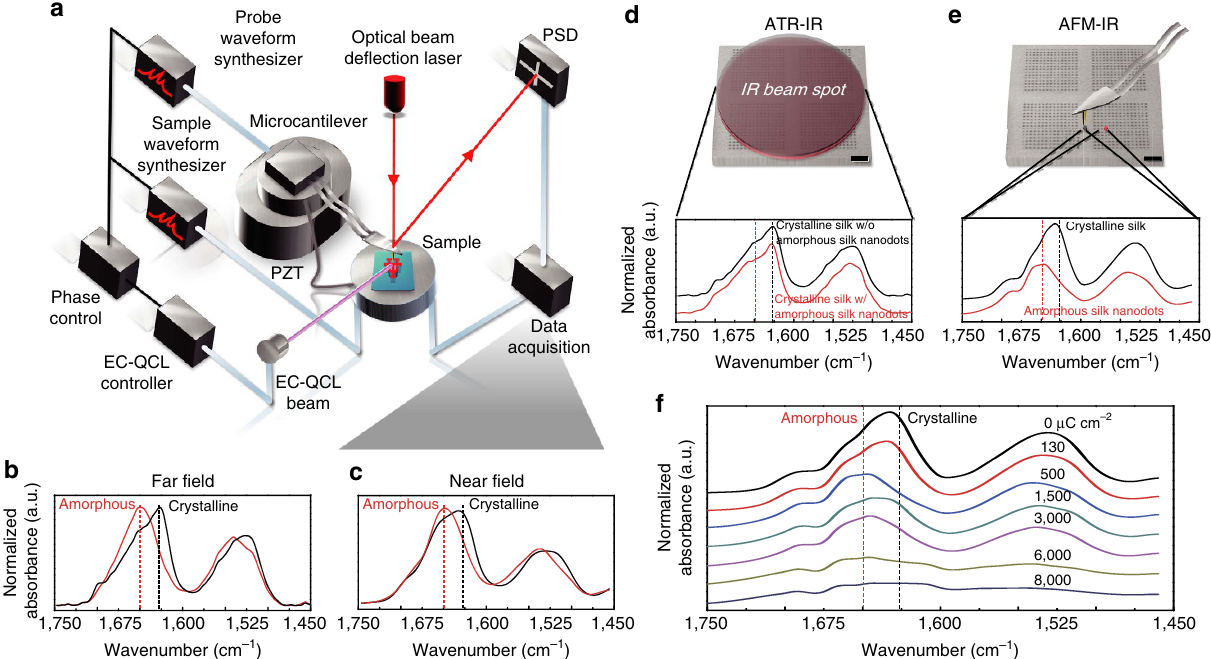
Figure 3 | Quantitative evaluation of conformational transitions in silk proteins using near-field IR nano-spectroscopy. ( a ) Schematics of IR nano-spectroscopy using AFM–IR: pulses of IR radiation emitted by an IR QCL (output range: 1,460–1,780cm (cid:2) 1 , swept by a step size: 1cm (cid:2) 1 ) were used to illuminate the sample, causing a rapid thermal expansion of silk nanostructures due to local absorption enhancement at various stages picked by the AFM tip, corresponding to the absorption spectroscopic signatures. ( b , c ) The AFM–IR spectra on amorphous and crystalline silk thin films are consistent with the conventional bulk FTIR spectra. ( d , e ) Spectra of a crystalline silk thin film with embedded amorphous silk nanopatterns of B 30nm fabricated using EBL, characterized by attenuated total reflection IR (ATR-IR) and AFM–IR, respectively. AFM–IR offers a considerable advancement ( (cid:3) B 1,000 improvement spatially) in distinguishing nanoscale structural heterogeneity. ( f ) AFM–IR spectra of electron-induced structural transitions in silk proteins.